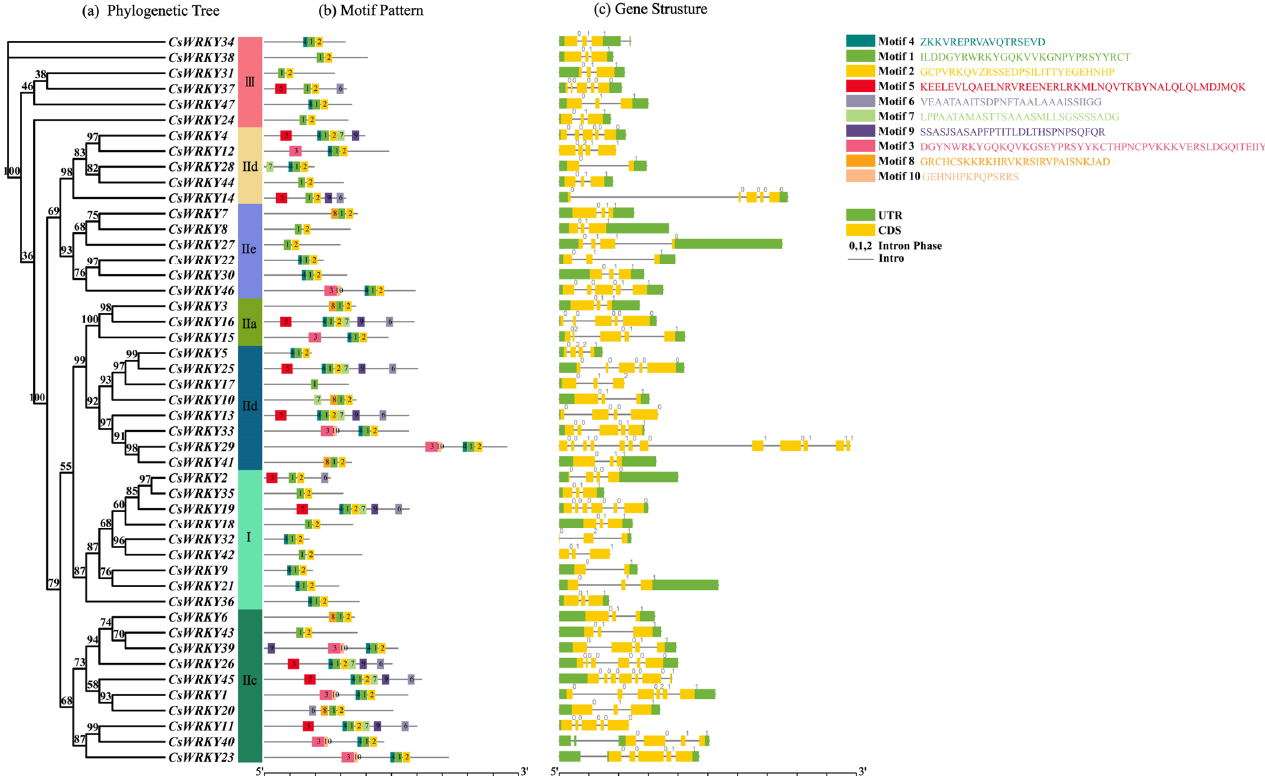
Figure 4. Phylogenetic relationship, motif composition, and coding gene structure of WRKY TFs. ( a ) The phylogenetic tree was constructed based on the full-length amino acid sequences of CsWRKY TFs by IQ-TREE. ( b ) The forty-seven motifs of CsWRKY TFs were predicted by the MEME. Different colored boxes and numbers indicated various motifs, and numbers 1–10 were shown correspondingly in the various colored boxes. Short sequences of various motifs have been annotated behind them. ( c ) Intron-exon structures for forty-seven genes were derived from the TBtools software. Exons, introns, and non-coding regions (UTRs) were indicated by green boxes, gray lines, and yellow boxes, respectively. The numbers 0, 1, and 2 represent the phase information of the intersection point between introns and exons.